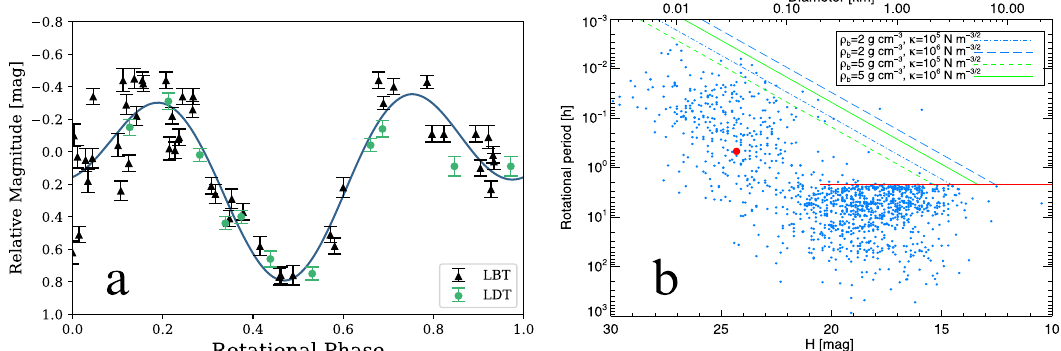
Fig. 1 Kamo ʻ oalewa lightcurve and Rotational Properties. Combined lightcurve of Kamo ʻ oalewa from LBT and LDT, phased to a rotational period of 28.3 minutes a , with comparison to the known sample of small near-Earth objects b , Kamo ʻ oalewa indicated as the large red point). We fi nd that the observations are well described by a double-peaked lightcurve with asymmetric minima (blue curve, left panel) with an amplitude of 1.07 ± 0.05 mag. Though it rotates faster than the 2.2 h strengthless spin barrier seen with larger asteroids, when compared to similarly-sized NEOs, Kama ’ oalewa ’ s spin period is typical. The diagonal curves in the right panel indicate limits of rotational breakup for asteroids given several assumed bulk densities ( ρ b ) and tensile strength coef fi cients ( κ ). Translation from absolute magnitudes (H) to diameter 58 assumes a geometric albedo of 0.20. The lightcurve is shown with photometric uncertainties (random error) as the error